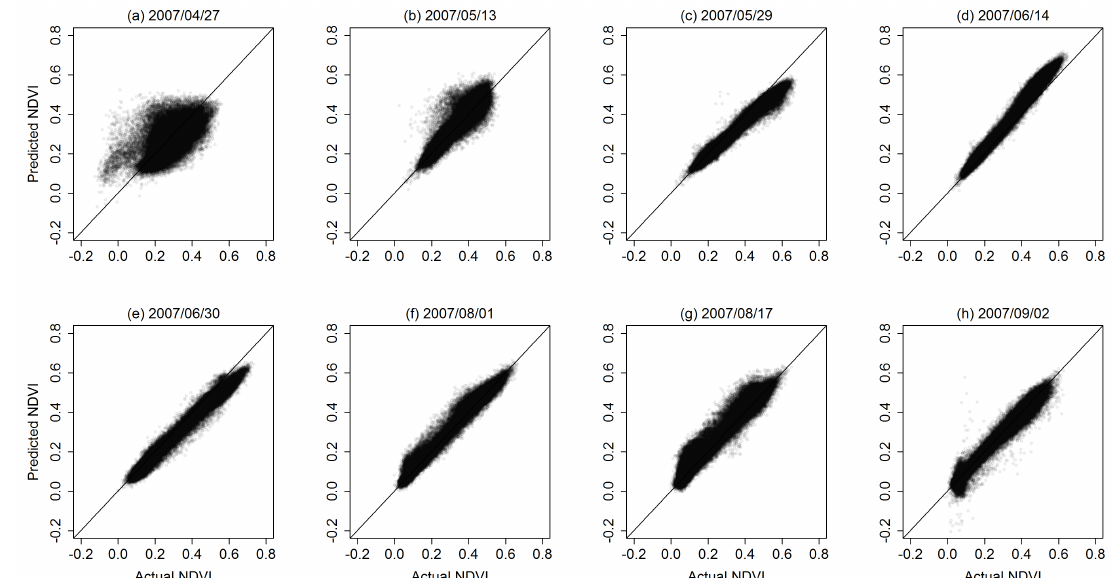
Figure 9. Regression graphs for actual (Landsat) normalized difference vegetation index (NDVI) and STARFM-predicted NDVI over the 2007 growing season at Dry Creek Experimental Watershed (DCEW), Idaho, USA or ( a ) 27 April 2007, ( b ) 13 May 2007, ( c ) 29 May 2007, ( d ) 14 June 2007, ( e ) 30 June 2007, ( f ) 1 August 2007, ( g ) 17 August 2007, and ( h ) 2 September